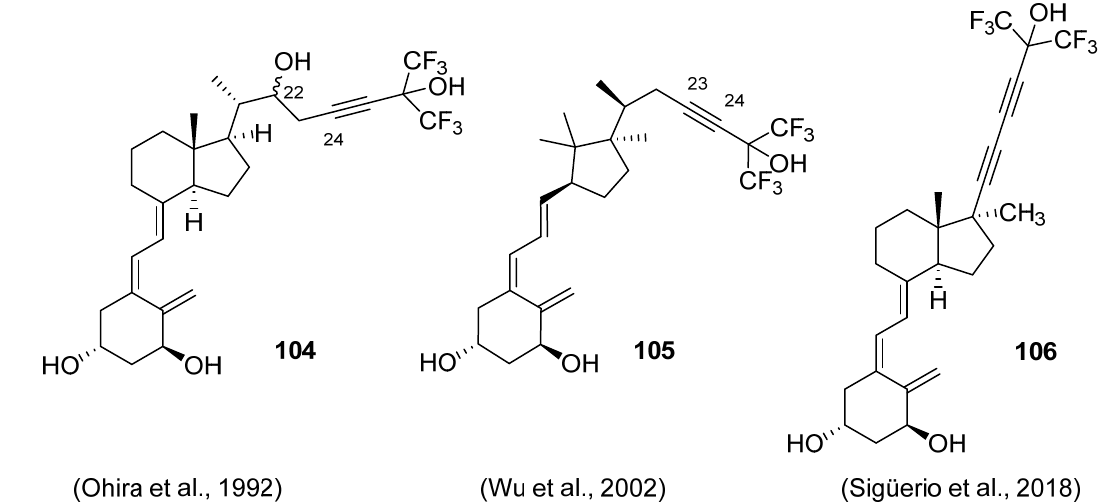
Scheme 36. Combination of the hexafluoropropanol unit derived from hexafluoroacetone (HFA) and triple bond(s), which brought conformational rigidity to the side chain.